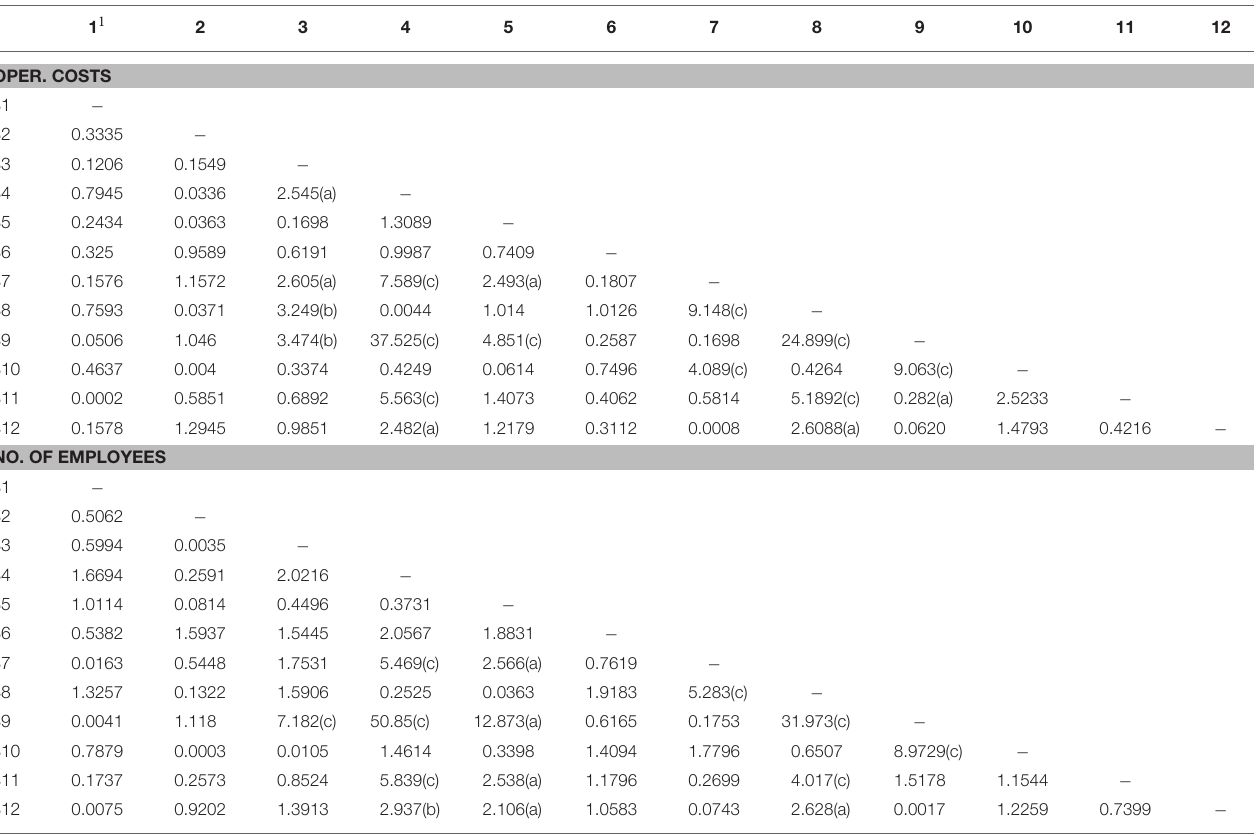
TABLE 7 | Wald test to evaluate whether sectoral FT coefficients are pair-wise significantly different (two